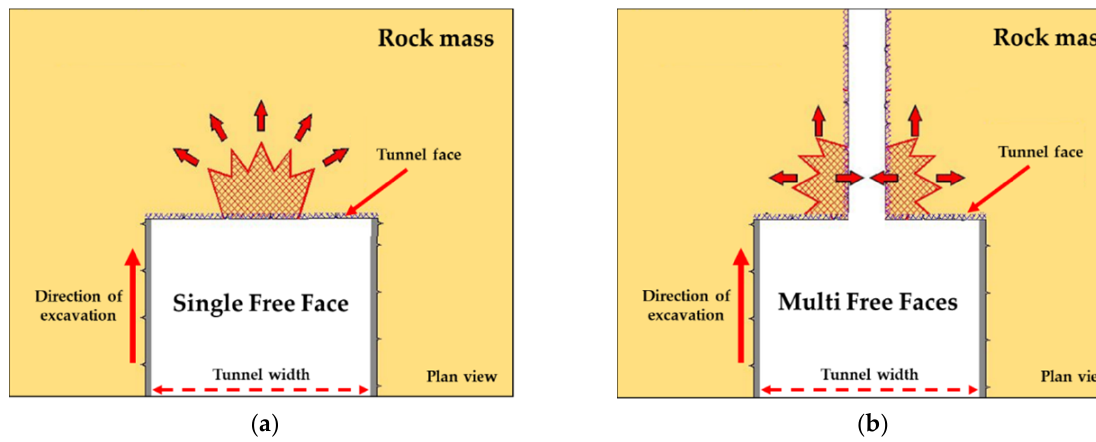
Figure 1. Comparison of the principle between ( a ) general blasting method and ( b ) multi-setting smart-investigation of the ground and pre-large hole boring (MSP) method.